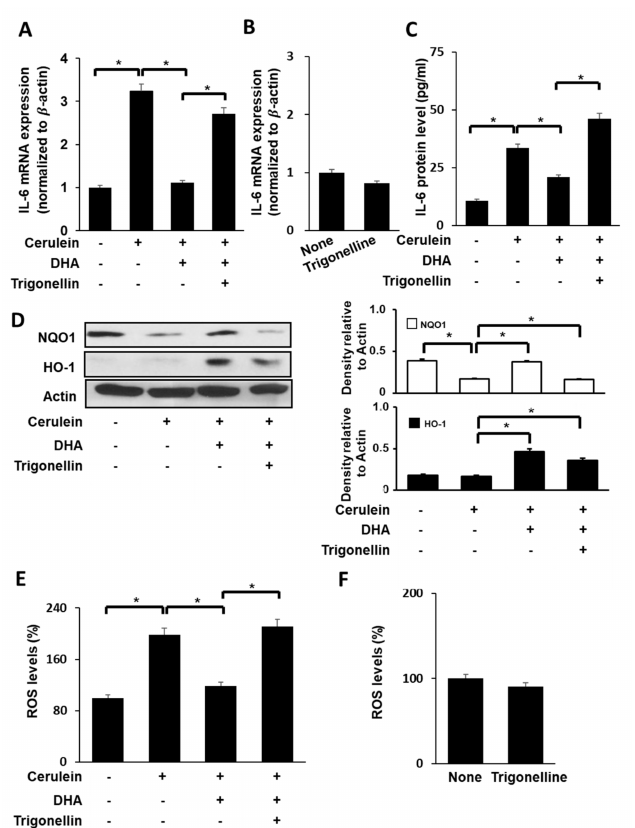
Figure 4. E ff ect of Nrf2 inhibitor trigonelline on the expression of IL-6, NQO1, and HO-1, and ROS levels in cerulein-stimulated DHA-treated AR42J cells. ( A ) Cells (2 × 10 5 / well) were pretreated with trigonelline (5 µ M) in the presence of DHA (50 µ M) for 1 h, and stimulated with cerulein for 6 h. IL-6 mRNA expression was determined by real-time PCR analysis and normalized to β -actin mRNA expression. ( B ) Cells (2 × 10 5 / well) were treated with trigonelline (5 µ M) alone for 7 h. IL-6 mRNA expression was determined by real-time PCR analysis and normalized to β -actin mRNA expression. ( C ) Cells (2 × 10 5 / well) were pretreated with trigonelline (5 µ M) in the presence of DHA (50 µ M) for 1 h and stimulated with cerulein for 24 h. IL-6 concentration in the culture medium was determined using ELISA. ( D ) Cells (8 × 10 5 / dish) were pretreated with trigonelline (5 µ M) in the presence of DHA (50 µ M) for 1 h and stimulated with cerulein for 1 h. Protein levels of HO-1 and NQO1 in whole-cell extracts were determined by Western blot analysis, using actin as the loading control (right panel). The densitometry data represent means ± S.E. from three immunoblots and are shown as relative density of protein bands normalized to actin level (left panel). ( E ) Cells (2 × 10 5 / well) were treated with trigonelline (5 µ M) in the presence of DHA (50 µ M) for 1 h and stimulated with cerulein for 1 h. Then, cells were incubated with 10 µ g / mL DCF-DA for 30 min and washed with PBS. Cellular ROS levels were determined by measuring the level of fluorescent DCF. ( F ) Cells (2 × 10 5 / well) were treated with trigonelline alone (5 µ M) for 2 h. Then, cells were incubated with 10 µ g / mL DCF-DA for 30 min and washed with PBS. Cellular ROS levels were determined by measuring the level of fluorescent DCF. Intracellular ROS levels are expressed as the relative increase. The value for ROS levels in unstimulated cells (cells without cerulein) in the absence of DHA was set as 100%. Data are expressed as the mean ± S.E. of three independent experiments. * p < 0.05. + , with treatment; − , without